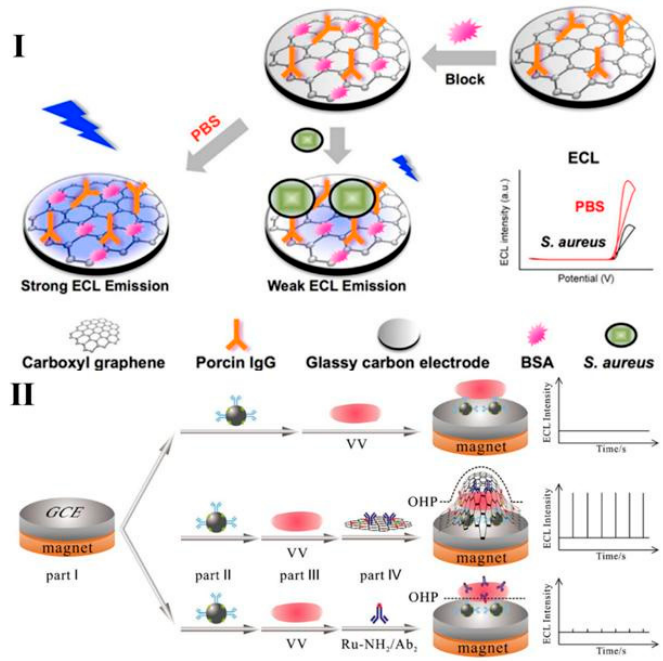
Figure 1. ( I ) Schematic of a label-free ECL pathway for Staphylococcus aureus ( S. aureus ) detection based on specific recognition between IgG and S. aureus protein A (SPA). Reproduced with permission from [71], published by Elsevier B.V, 2016. ( II ) Schematic of Faraday cage-type ECL immunosensor for detection of Vibrio vulnificus . Reproduced with permission from [63], published by Springer-Verlag Berlin Heidelberg,